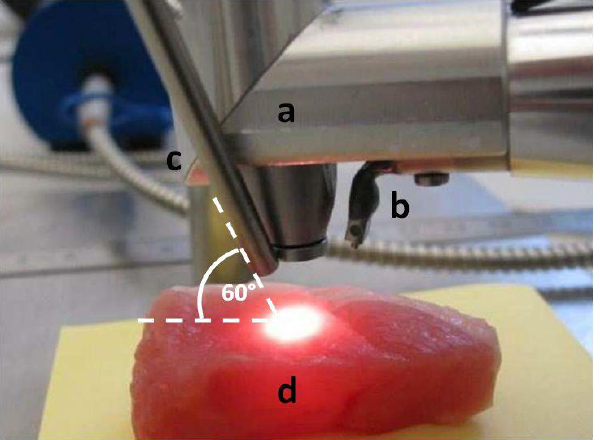
Figure 3. Experimental set-up for laser ablation and optical measurements: ( a ) Hand piece of the Er:YAG laser. ( b ) Internal system for spray cooling. ( c ) Reflection/backscattering probe. ( d ) Tissue sample (in that case muscle tissue, ex vivo ,